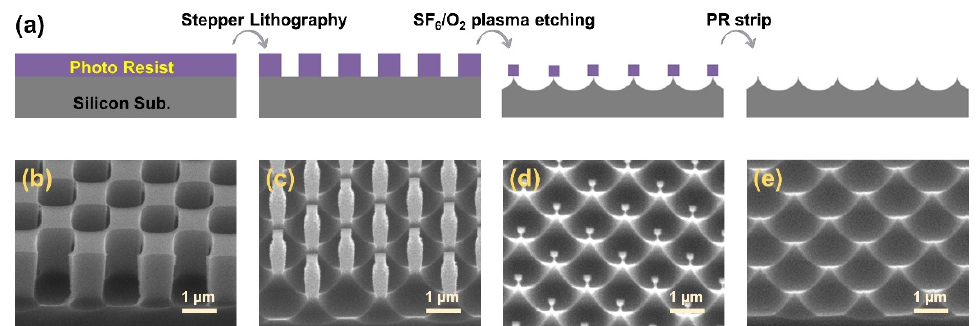
Figure 2. ( a ) The process schematic diagram of an inverse moth-eye microstructure. ( b – e ) SEM images according to the process steps: ( b ) grating patterns by the lithography process, etching profile ( c ) at the beginning and ( d ) end of the process depending on etch time, and ( e ) inverse moth-eye structure after PR strip